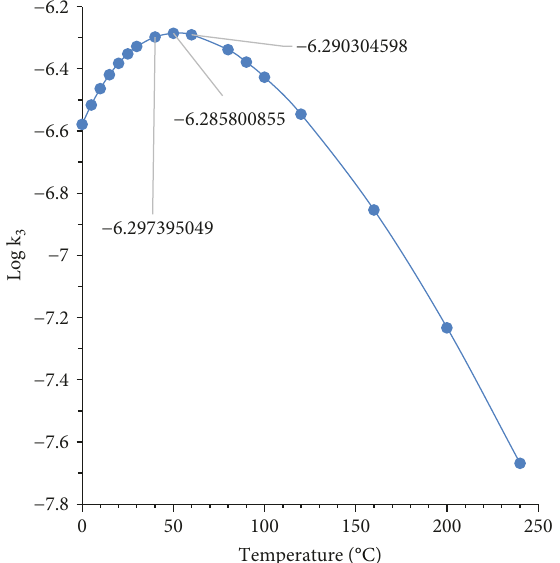
Figure 12: Change in the primary ionization constant of carbonic acid ( log k ) with the temperature. 3